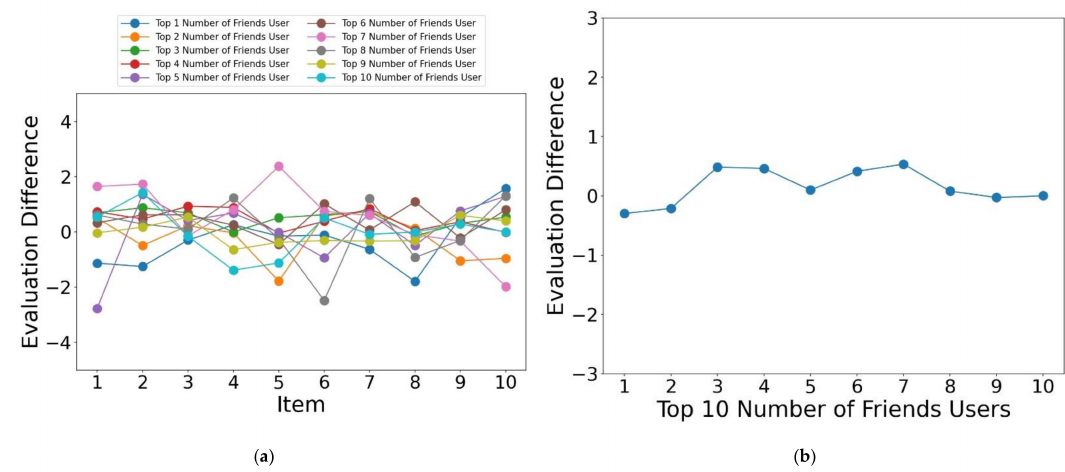
Figure 8. Evaluation difference between the top 10 users with a large number of friends and the average of all users: ( a ) the difference is shown for each restaurant; ( b ) the average evaluation difference is shown for each top 10 users with a large number of friends.